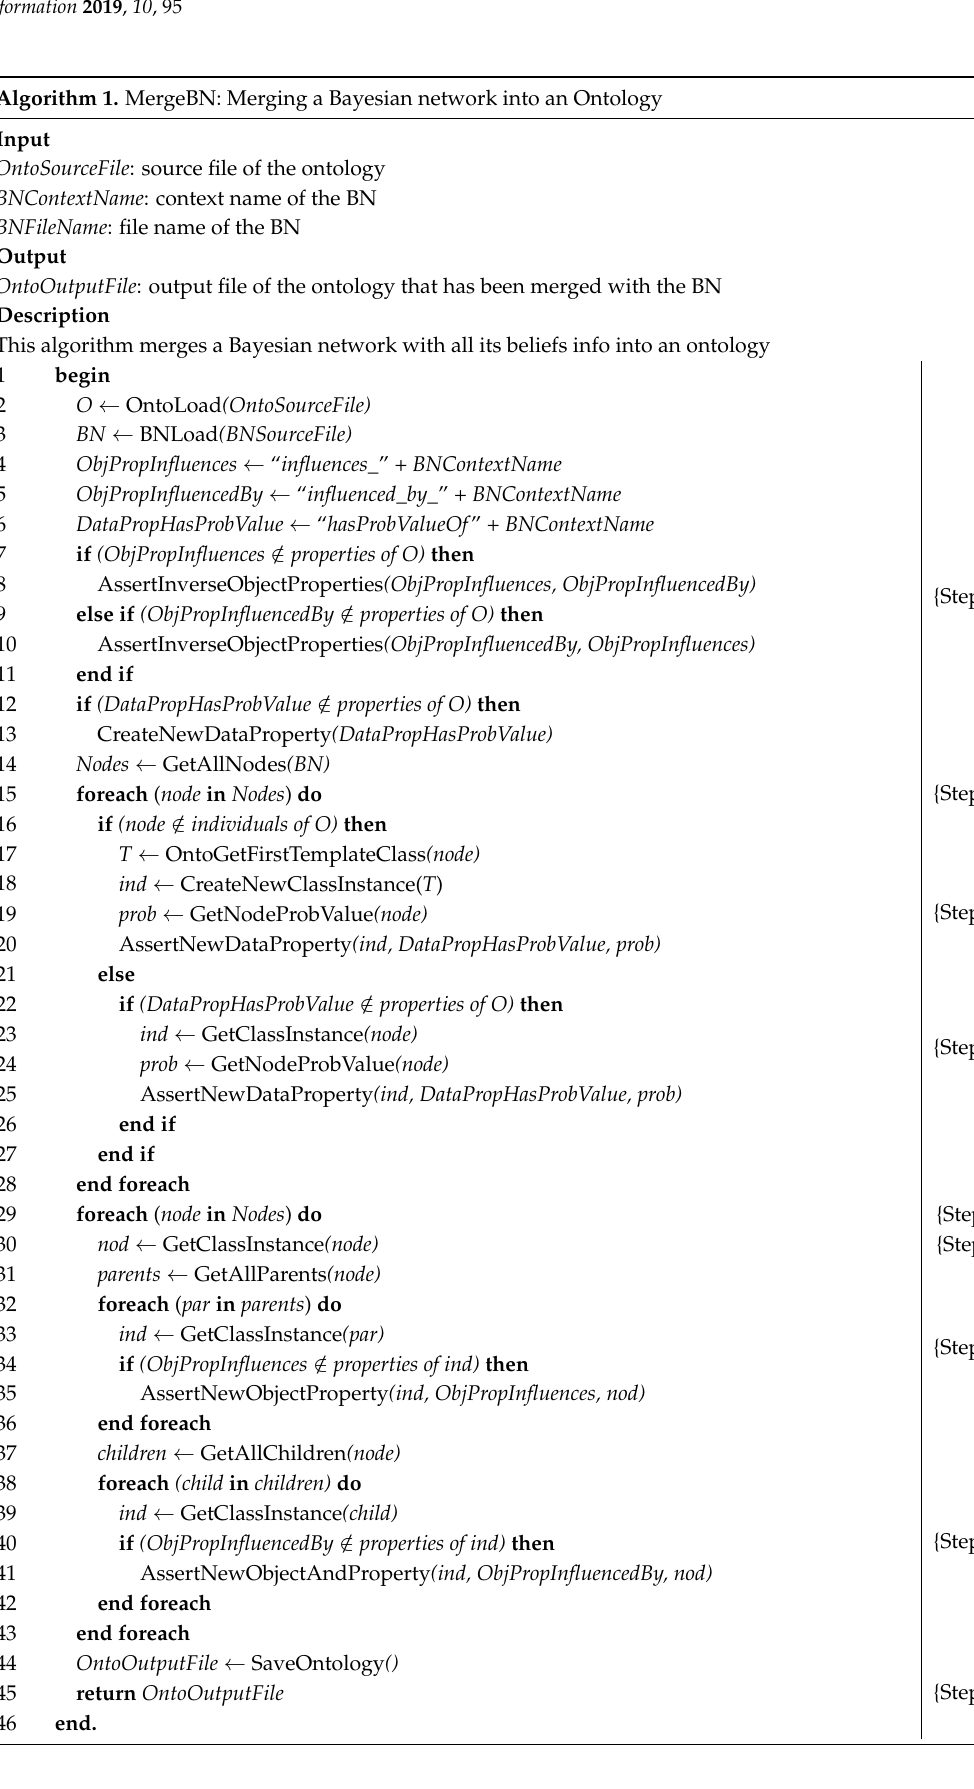
Algorithm 1. MergeBN: Merging a Bayesian network into an